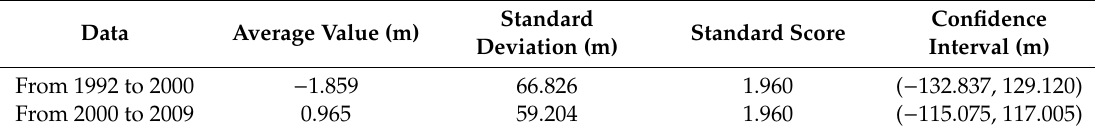
Table 3. Confidence interval of elevation di ff erences for the periods ranging from 1992 to 2000 and from 2000 to 2009.